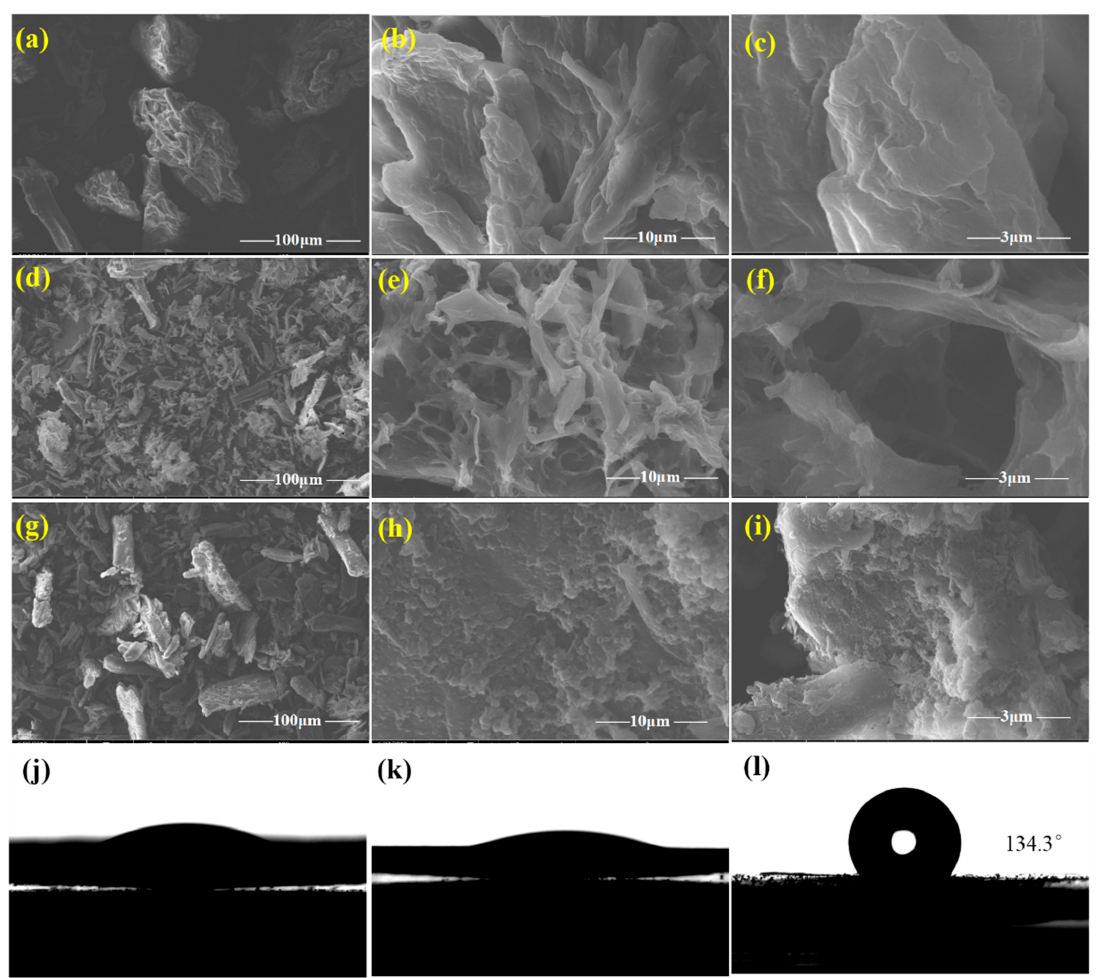
Figure 1. SEM micrographs of cellulose ( a – c ), cellulose-OH ( d – f ), cellulose-St ( g – i ), and the static sessile drop water contact angles of cellulose ( j ), cellulose-OH ( k ), cellulose-St ( l ). Moreover, the surface had irregular wrinkles and pores. In the view of macroscopic ob- servation shown in Figure S1 (from Supplementary Materials), the volume of the cellulose had a significant increase after being pretreated by alkali compared to the original cellu- lose at the same mass, as a result of the alkali treatment succeeding in swelling the cellu- lose fibers. The swelling allowed for more accessibility to the cellulose structure by in- creasing the surface area while reducing cellulose crystallinity and the degree of polymer- ization [45]. Alkali was thought to enhance hydrogenolysis conversion of cellulose to C2– C3 polyols [46]. In cellulose-St (Figure 1g–i), it can be found that the pores in the surface disappeared, and the surface was almost entirely covered with spherical irregular poly- styrene. It meant that the grafting reaction occurred uniformly on the surface and styrene was grafted onto cellulose in a non-fixed structure. Furthermore, in Figure S1, it was found that the volume had a sharp reduction when cellulose-OH was converted to cellulose-St, which meant the increase of density. It may be caused by an increase in molecular weight. Moreover, cellulose-St had no significant change in color compared to cellulose and cel- lulose-OH. The BET analysis (Table S1 and Figure S2, from Supplementary Materials)